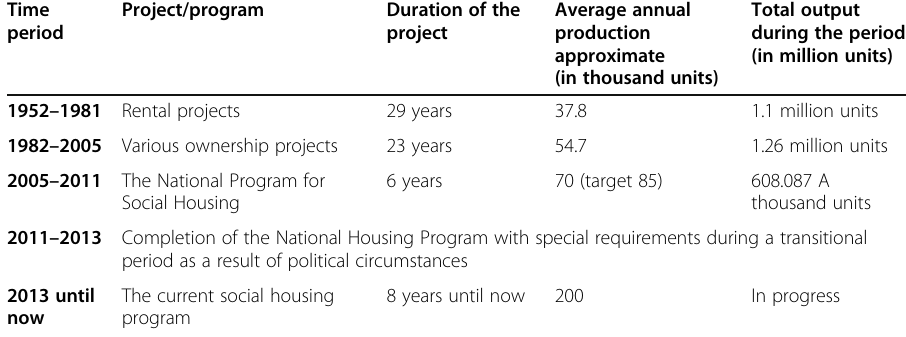
Table 1 The four phases of affordable housing programs in Egypt (The first author based on (Mortgage Finance Guarantee and Support Fund, 2018, page: